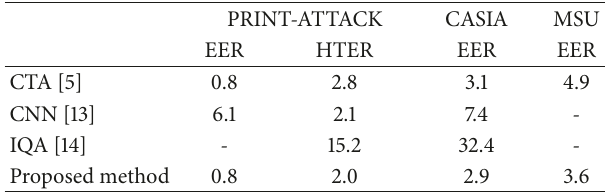
Table 7: Comparison between the proposed countermeasure and other literature methods on the three benchmark datasets.